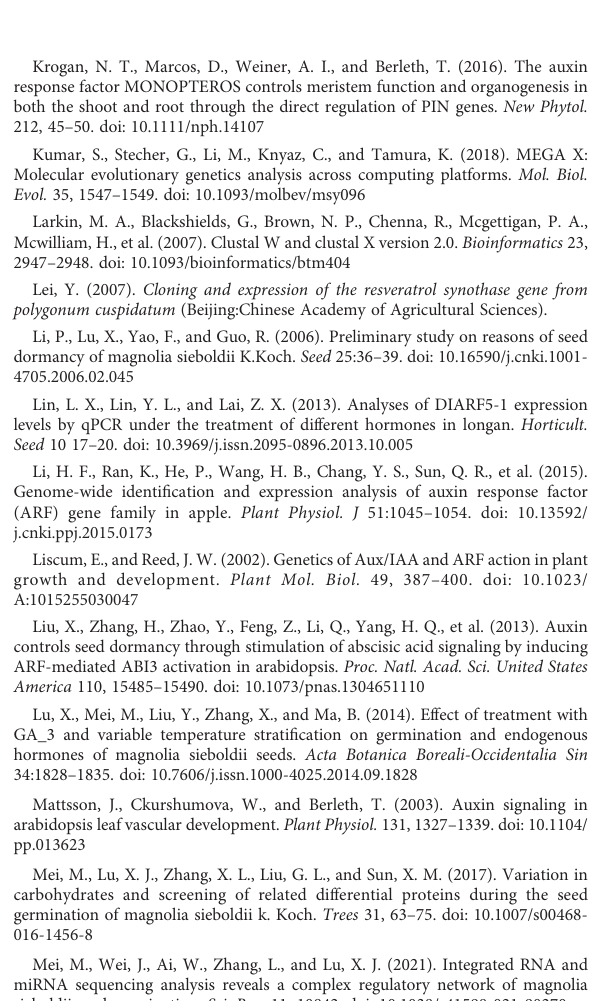
SUPPLEMENTARY FIGURE 1 Chromosomal distribution of MsARFs . SUPPLEMENTARY FIGURE 2 Gene structure analysis and motif characterization of MsARFs .